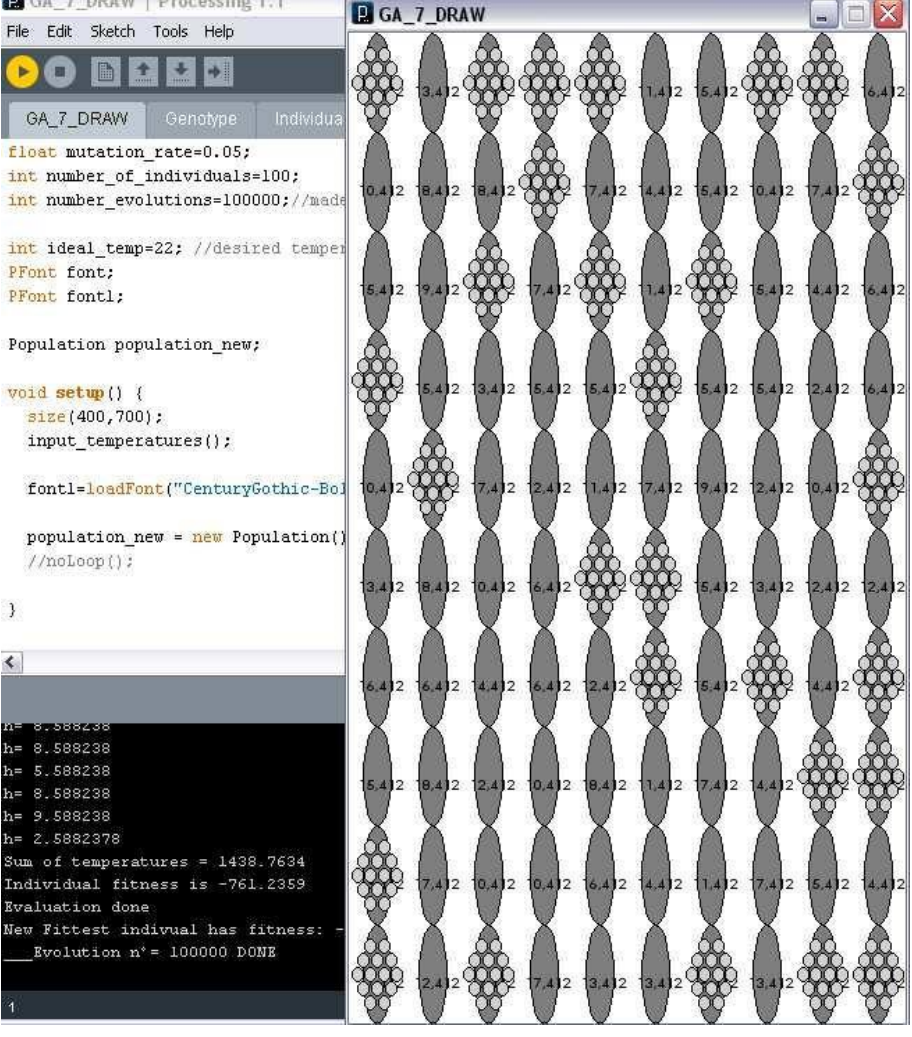
Figure 15. Results shown by no degree of openness